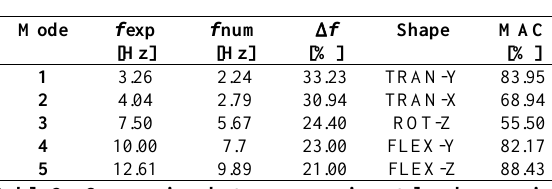
Table 2 – Comparison between experimental and numerical data considering the starting numerical model